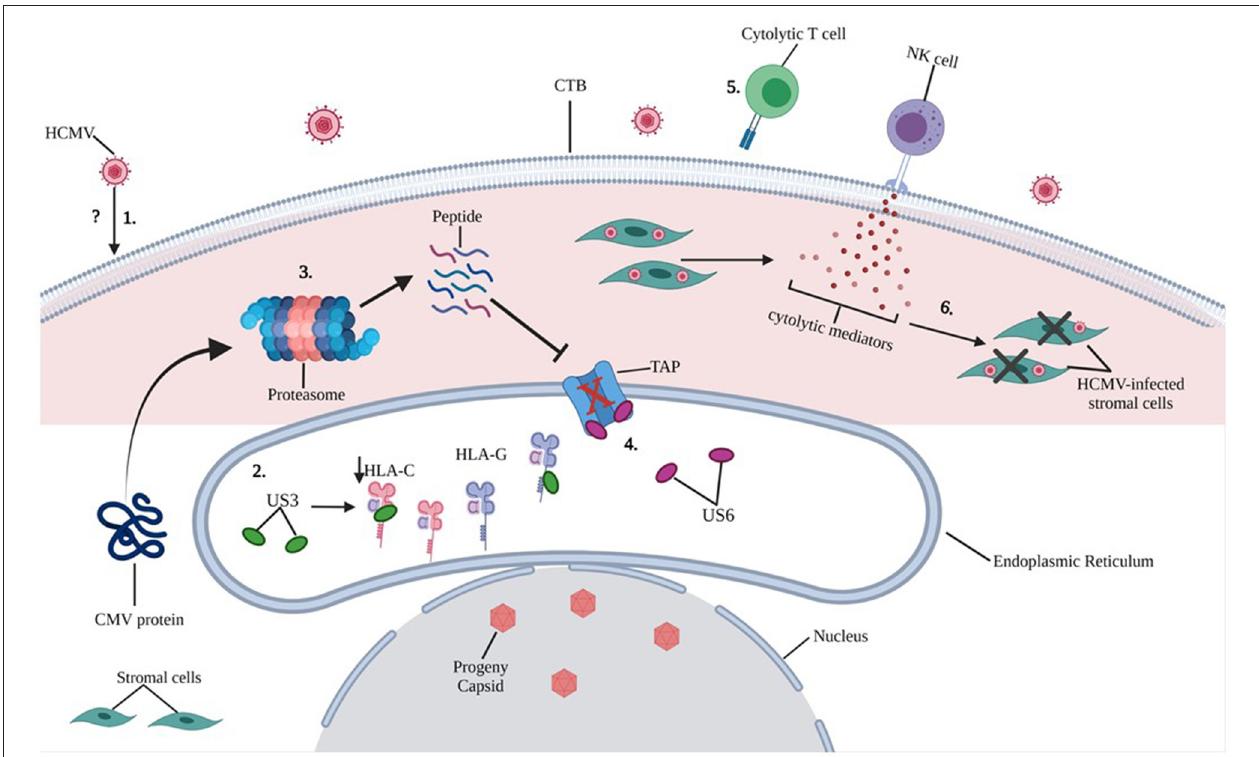
FIGURE 5 | Putative mechanisms of HCMV induced intracellular damage in trophoblast cells. 1) The exact mechanisms by which HCMV infects trophoblast cells remain unclear (refer to Figure 4 ), however, molecular mechanisms by which HCMV causes intracellular damage are well documented. 2) HCMV glycoprotein US3 directly binds to both HLA-C and HLA-G within the endoplasmic reticulum (ER) and blocks transportation of MHC molecules only partially downregulating HLA-C upon HCMV infection of primary EVT cells. 3) Cytoplasmic proteins are constantly monitored by proteosome processing and peptides are retrograde transported to the ER through transporter TAP to be loaded onto the MHC. 4) HCMV glycoprotein US6 inhibits the TAP, and the cytoplasmic peptide-including HCMV derived peptide are unable to enter the ER. 5) Because of reduced expression of MHC class I molecules on HCMV-infected CTBs, cytolytic T cell recognition is impaired. 6) NK cell-mediated cytolytic killing of HCMV-infected stromal cells may result in placental